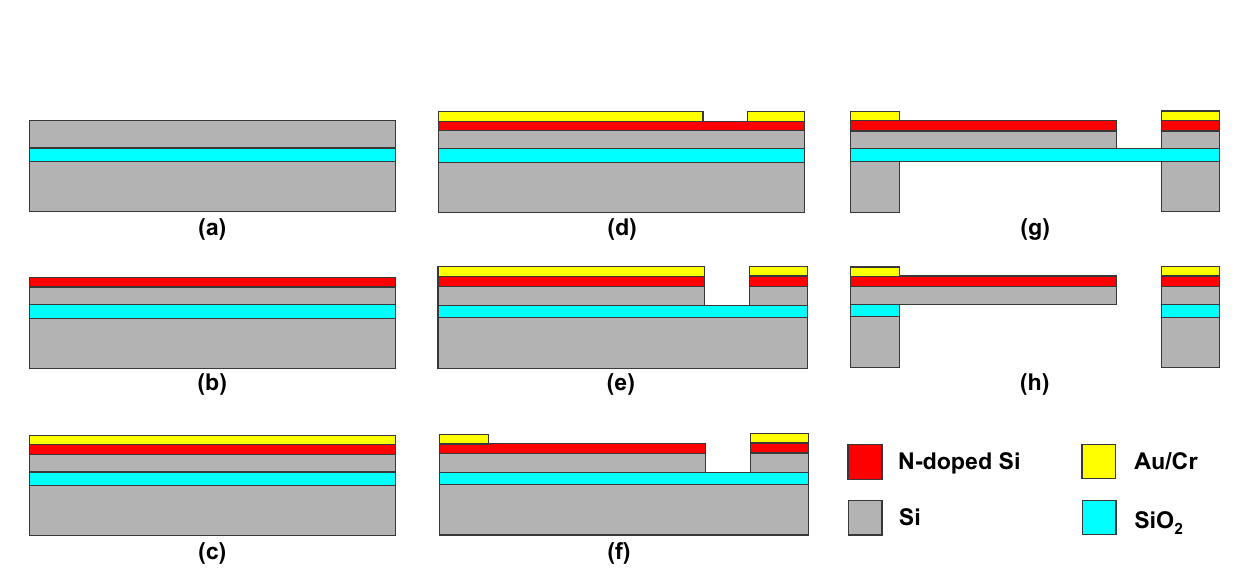
Figure 8. Fabrication process of the proposed cantilever-type acoustic